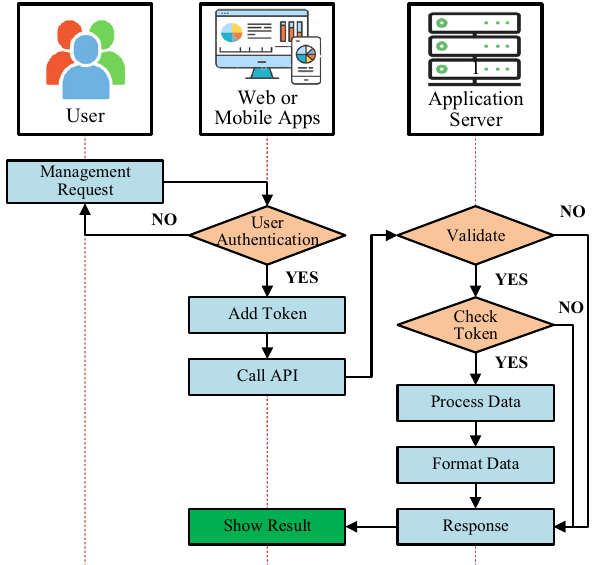
Figure 8. Flowchart of object management and configuration in the